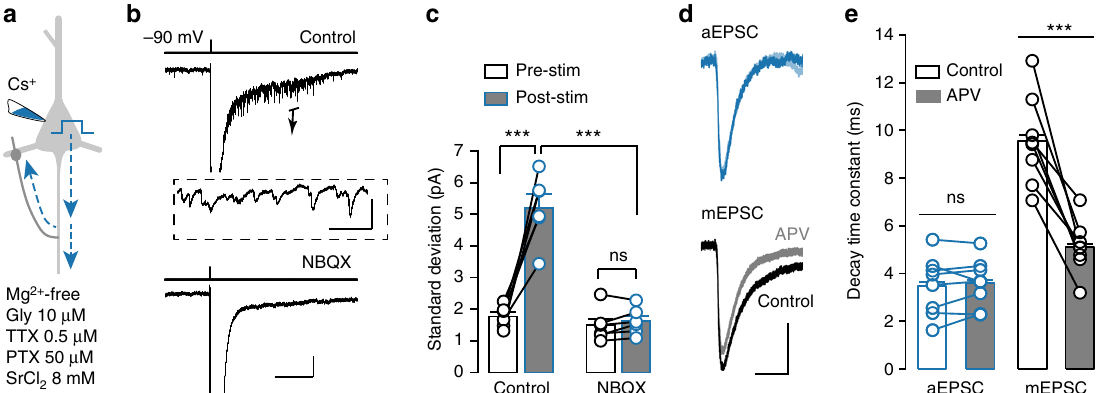
Fig. 5 Autaptic responses contain no NMDA component. a Schematic drawing of layer-5 PC recording in Mg 2 + -free ACSF (0 Ca 2 + , 8 mM Sr 2 + ) but with a cocktail of drugs that enhances NMDA responses (Gly), blocks AP generation (TTX), and mIPSCs (PTX). The Cs + pipette solution makes the cell electrically more compact and allow ef fi cient propagation of voltage pulses to autaptic contacts. b Desynchronized autaptic currents induced by somatic voltage pulses could be completely blocked by 10 μ M NBQX. Scale bars: 1 s/50 pA. Inset: an expanded trace showing autaptic current events, scale bars: 50 ms/50 pA. c Group data showing current noise levels pre and post pulse stimulation, before and after NBQX application (paired Student ’ s t -test). d Average traces of aEPSCs and baseline mEPSCs before and after APV (50 μ M) application. Scale bars: 10 ms/10 pA. e Group data showing the effect of APV on the decay time constant of aEPSC and mEPSC (paired Student ’ s t -test for both). Data are represented as mean ± SEM. *** P < 0.001; ns not signi fi